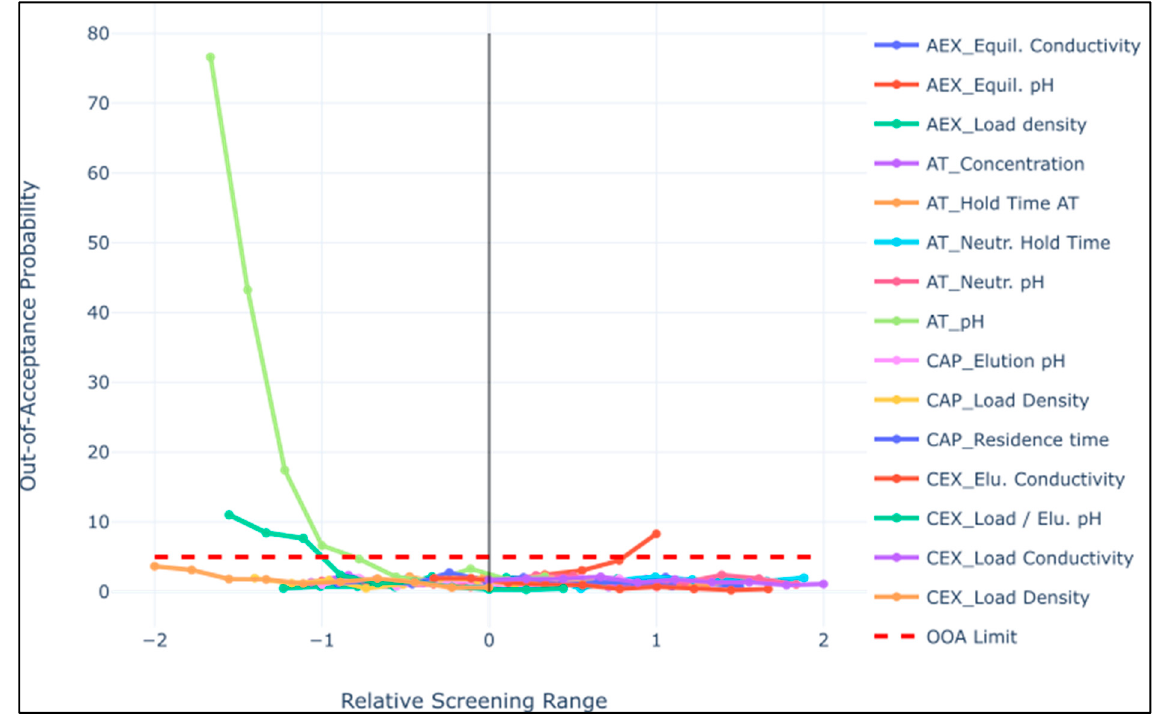
Figure 5. Relative screening range of CQA1 imp for all tested potential CPPs. The set point was coded to zero and the design space varied between − 2 and 2 based on where the set point lies.